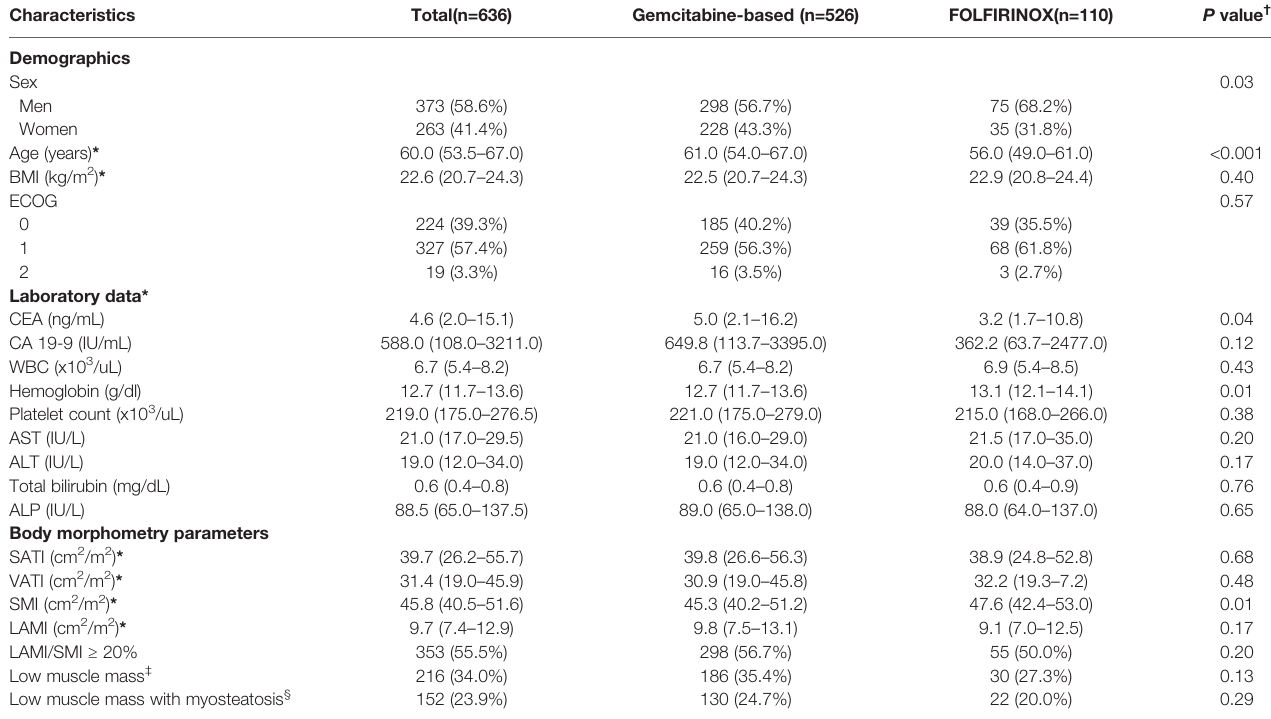
TABLE 1 | Characteristics of the included